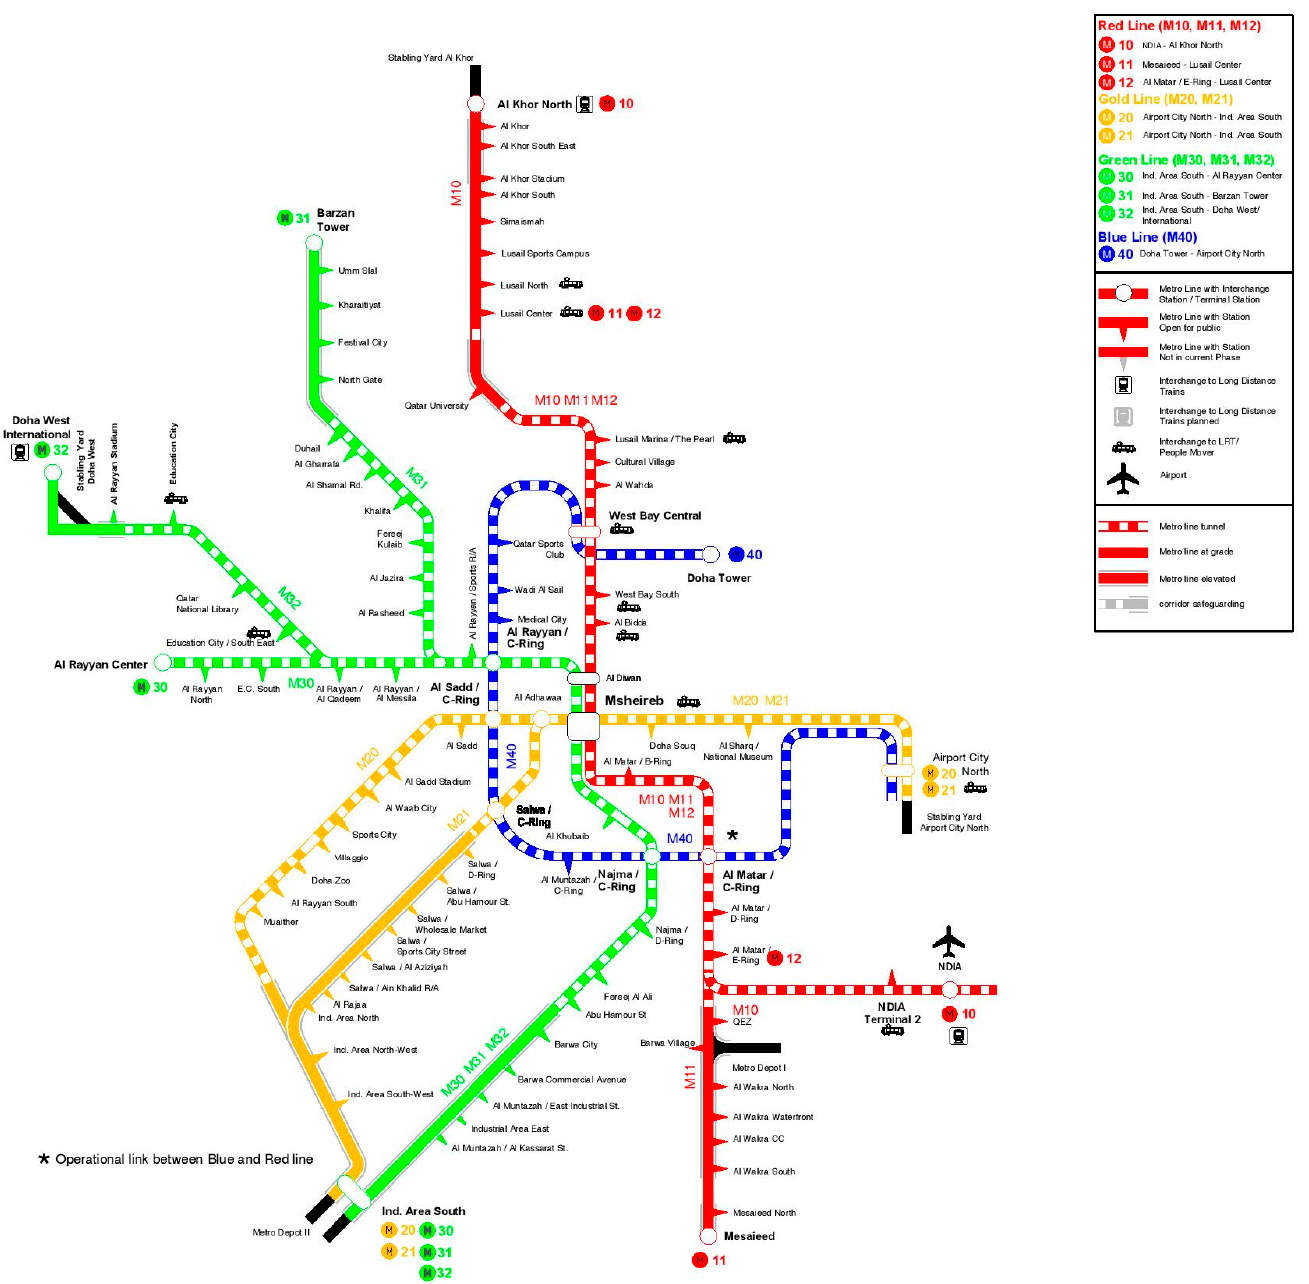
Figure 1. Doha Metro lines. The ‘*’ indicates a link between the red and blue lines. (Source: Qatar Rail).